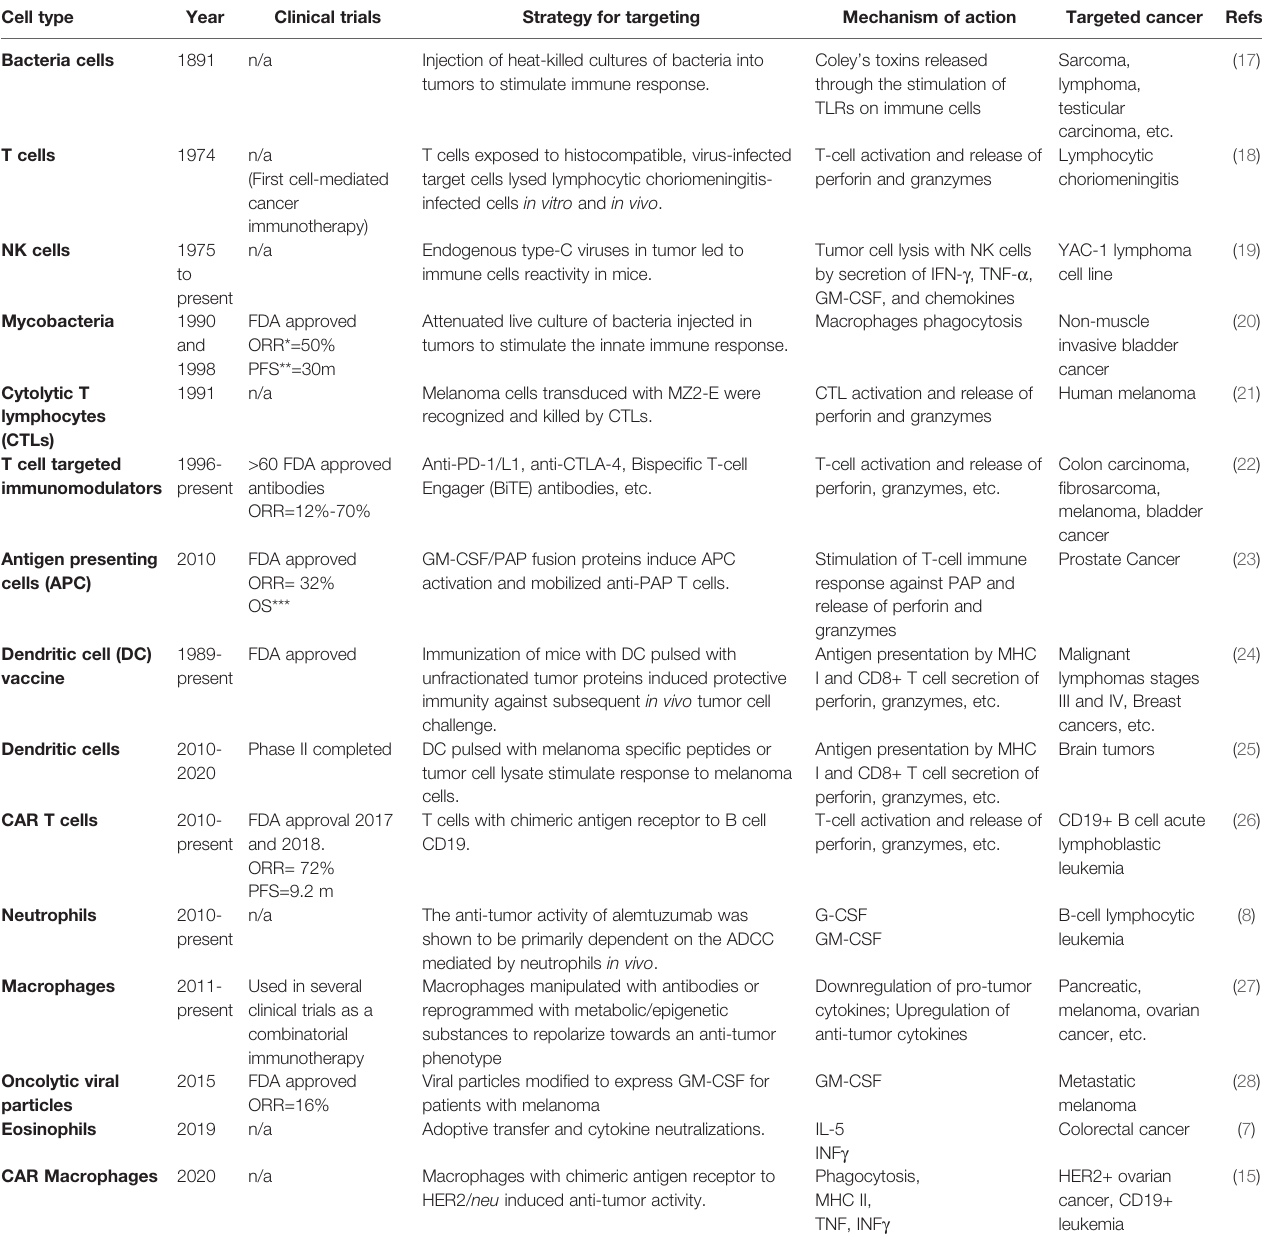
TABLE 1 | Chronological history of cell-mediated cancer immunotherapy